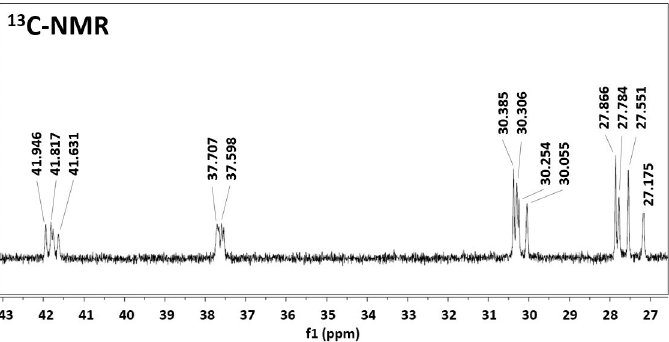
Figure 5. NMR spectrum of PA6.9-6 60-40 (in CD 3 COOD/HCOOH).